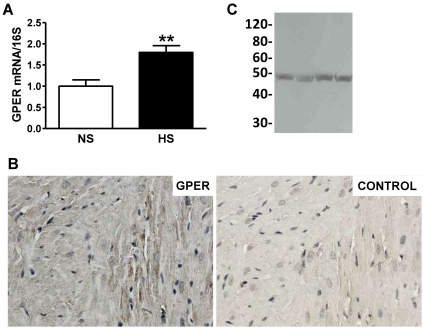
Cardiac GPER expression increases in salt-fed mRen2.Lewis females.
a. Cardiac GPER gene expression in female mRen2.Lewis rats fed a normal salt (NS) or high salt (HS) diet determined by real-time PCR and expressed as the ratio of GPER mRNA to S16 ribosomal RNA. Values are mean ± SEM; ** P<0.01. b. Left, representative GPER immunostaining in a cross section of the heart from an intact mRen2.Lewis female. Right, representative control section stained with pre-adsorbed primary antibody. c. Full-length immunoblot of cardiac membranes showing the specificity of the primary antibody using for immunohistochemistry as evidenced by a single band corresponding to the appropriate molecular weight of GPER (∼50 kDa).